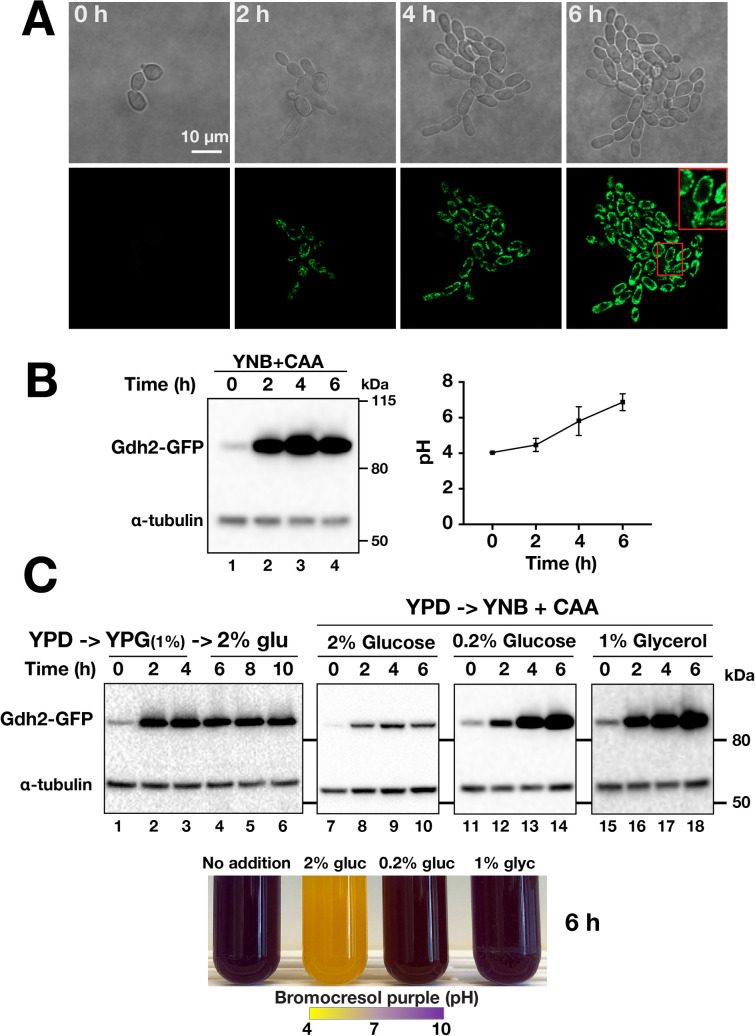
GDH2 expression is repressed by glucose.(A) Live cell imaging of Gdh2-GFP expression in cells (CFG273) shifted from YPD to YNB+CAA. Cells were pre-grown in YPD, transferred to a thin agar slab of YNB+CAA medium and observed by confocal microscopy at 37°C. Growth and the intensity of mitochondrial-localized GFP signal were monitored every hour for 6 h (images at 2 h intervals are shown). A region in the 6 h micrograph is enlarged (see inset). (B) Gdh2-GFP expression is rapidly induced in cells shifted from YPD to YNB+CAA. Cells were pre-grown in YPD and used to inoculate liquid YNB+CAA (OD600 ≈ 2.0); at the times indicated, the pH was measured (right panel; average of 3 independent experiments) and the levels of Gdh2-GFP expression (left panel) were monitored by immunoblot analysis. (C) Gdh2 expression is carbon source dependent. (upper panels) Cells grown in YPD (OD600 ≈ 2.0) were harvested, transferred to YPG (YP + 1% glycerol; lanes 1–3) and after subsampling at 6 h, 2% glucose was added to cultures (lanes 5–6); YPD grown cells (OD600 ≈ 2.0) were shifted to YNB + CAA with 2% glucose (lanes 7–10), 0.2% glucose (lanes 11–14) or 1% glycerol (lanes 15–18) and grown at 37°C. Extracts were prepared at the times indicated and the levels of Gdh2-GFP and tubulin (loading control) were assessed by immunoblotting using primary α-GFP and α-tubulin antibodies. (Lower panel) Photograph of tubes after 6 h of growth in YNB+CAA containing BCP without an additional carbon source (No addition), supplemented with 2% glucose, 0.2% glucose or 1% glycerol as indicated.